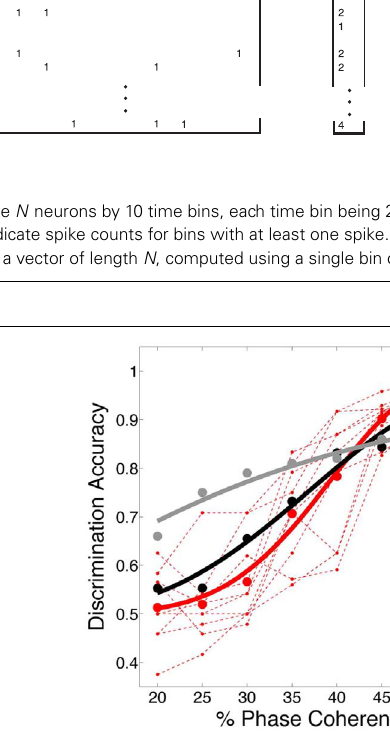
FIGURE 8 | Decoding accuracy compared to a feedforward model. Comparison of psychometric and two neurometric curves, one for sparse linear decoding of activity generated by our dynamicalV1 model (black curved – same as Figure 7A , D = 3.19, p = 0.53;) the other for a sparse linear decoding of activity generated by the first layer of the feed forward HMAX model (gray curve; D = 48.26 ( p < 0.01). Code for simulating HMAX feedforward model is freely available from http://cbcl.mit.edu/jmutch/ cns/hmax/doc/